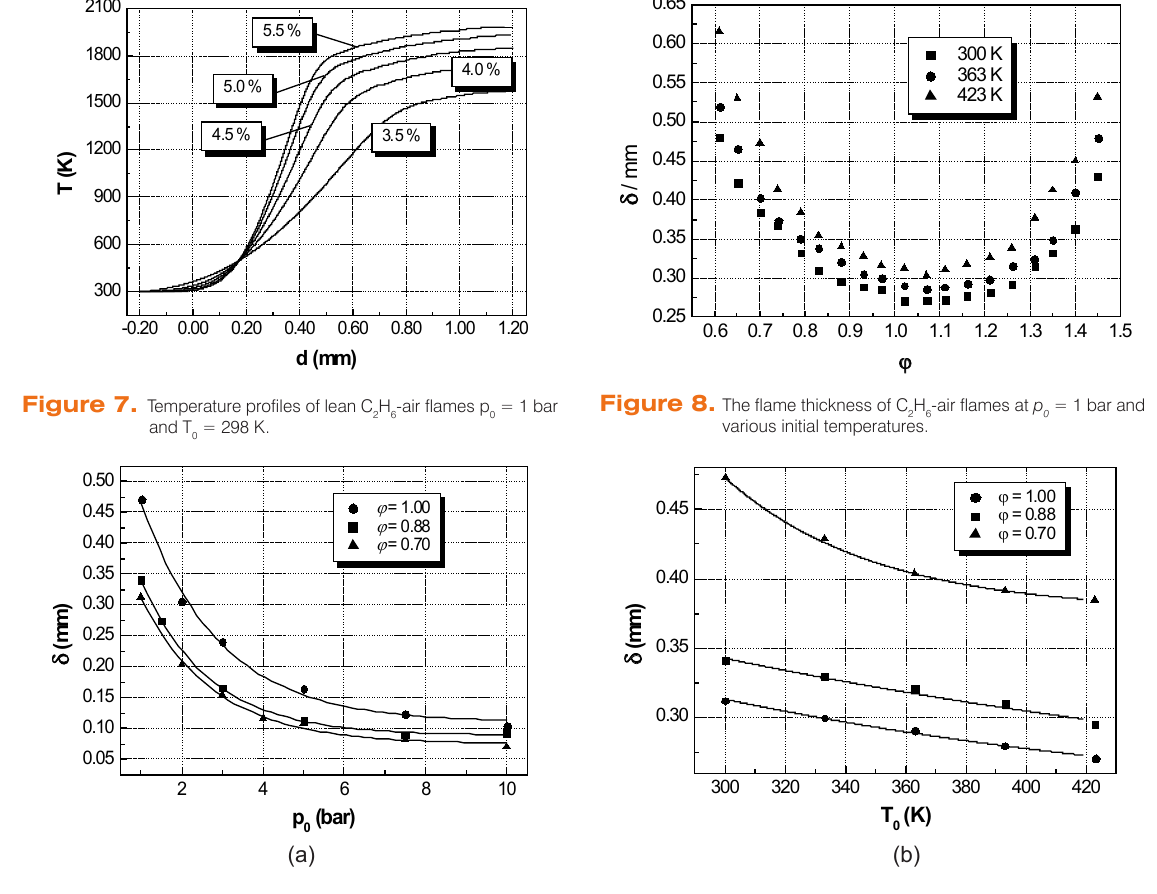
Figure 9. Flame thickness of lean and stoichiometric C